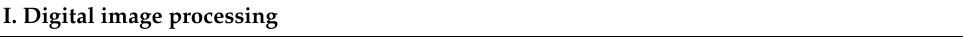
Table 4. DIP and 3D reconstruction algorithm for the non-homogeneous and the homogeneous MVS